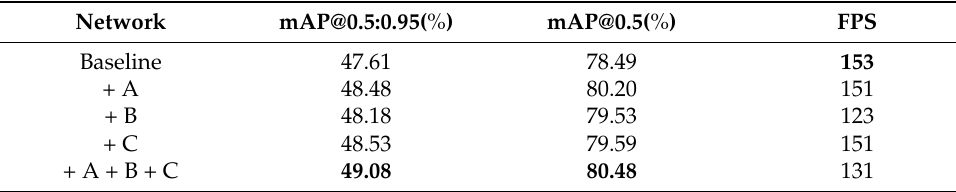
Table 7. Results of ablation experiments in the NEU-DET